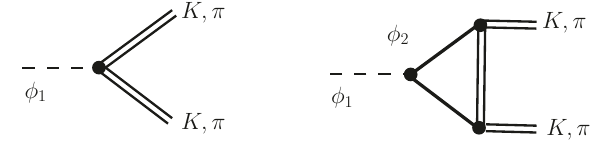
(cid:13)(cid:13) , matching onto the coupling h 1 (cid:13)(cid:13) . !